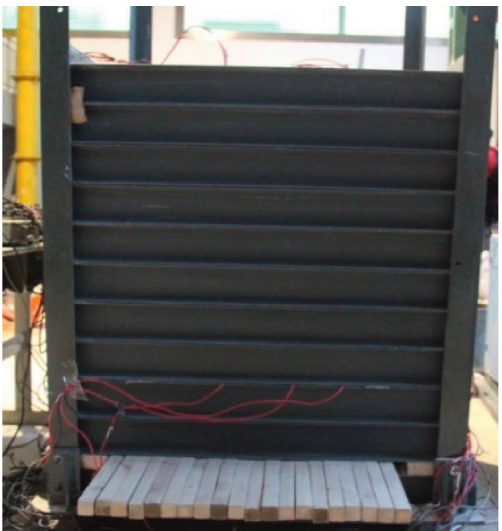
Figure 7: Cut-hole of the three-dimensional